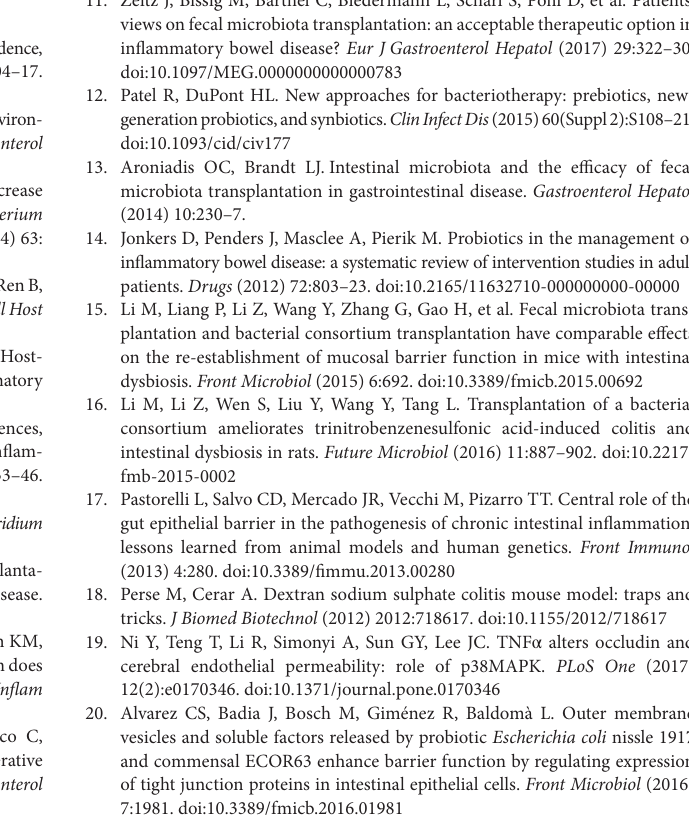
FigUre s1 | The composition of bacterial composition in different experimental groups at Class and Order levels. FigUre s2 | Heatmaps of the abundance of the dominant Phyla (a) , Family (B) , and Genera (c) in different groups. The relative abundance of each microbial group was normalized, and the Z -value was presented and depicted by the color intensity. FigUre s3 | The specific bacterial groups that are significantly manipulated by BCT. The MetaStat method was used to identify the significantly reduced or elevated microbial groups by DSS treatment and was reversed by BCT. k, kingdom; p, phylum; c, class; o, order; f, family; g, genus; All values